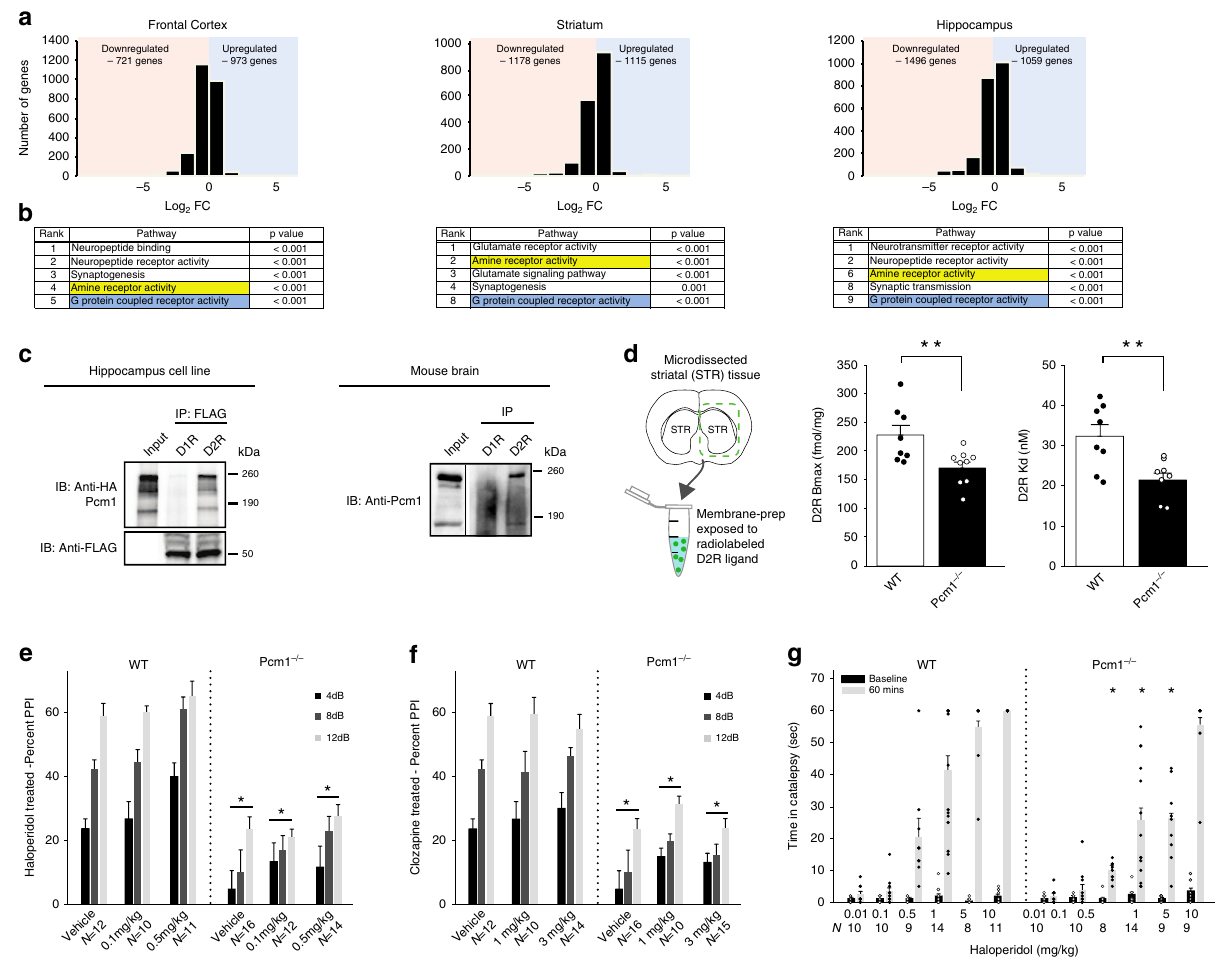
Fig. 4 Altered dopaminergic signaling components in Pcm1 − / − mice. a mRNA sequencing from three brain regions in WT and Pcm1 − / − adults ( N = 3/ genotype, 3 regions per subject): total number of genes up-regulated and down-regulated are plotted on a log 2 FC scale. b Gene set enrichment analysis revealed amine and G protein coupled receptor activity pathways were altered across the three brain regions. c Immunoprecipitations for D1R (dopamine D1 receptor) and D2R (dopamine D2 receptor), followed by western blot for Pcm1 in mouse hippocampal cell lines and mouse brain homogenates. d Striatal (STR) membrane preparations from WT and mutant brains were dissected, membranes were isolated, and binding studies were instituted with the radiolabeled D2R antagonist [ 3 H]-raclopride. Both the D2R Bmax and Kd levels were reduced signi fi cantly in samples from mutant mice ( N = 8 WT, N = 9 Pcm1 − / − ; p = 0.01 (Bmax); p = 0.004 (Kd)). ANOVA with post-hoc Bonferroni adjustment. e , f PPI responses from P90-120 WT and Pcm1 − / − mice indicate that mutants fail to respond at WT levels upon exposure to different doses of haloperidol ( e ) (Overall genotype effect, p = 0.001 PPI x genotype) or clozapine ( f ) (Overall genotype effect, p = 0.001). g Catalepsy in WT and Pcm1 − / − mice after 0.5, 1, 5, and 10 mg kg − 1 haloperidol ((RMANOVA Pre/ Post × Treatment × Genotype, p = 0.002)). e – g N shown in graph, analyzed as RMANOVA with post-hoc Bonferroni adjustment. Data shown as mean ± SEM, * p < 0.05, WT vs. Pcm1 − / − . Source data and detailed statistical information are provided as a Source Data File. RNAseq data has been made publicly available. Illustrations are